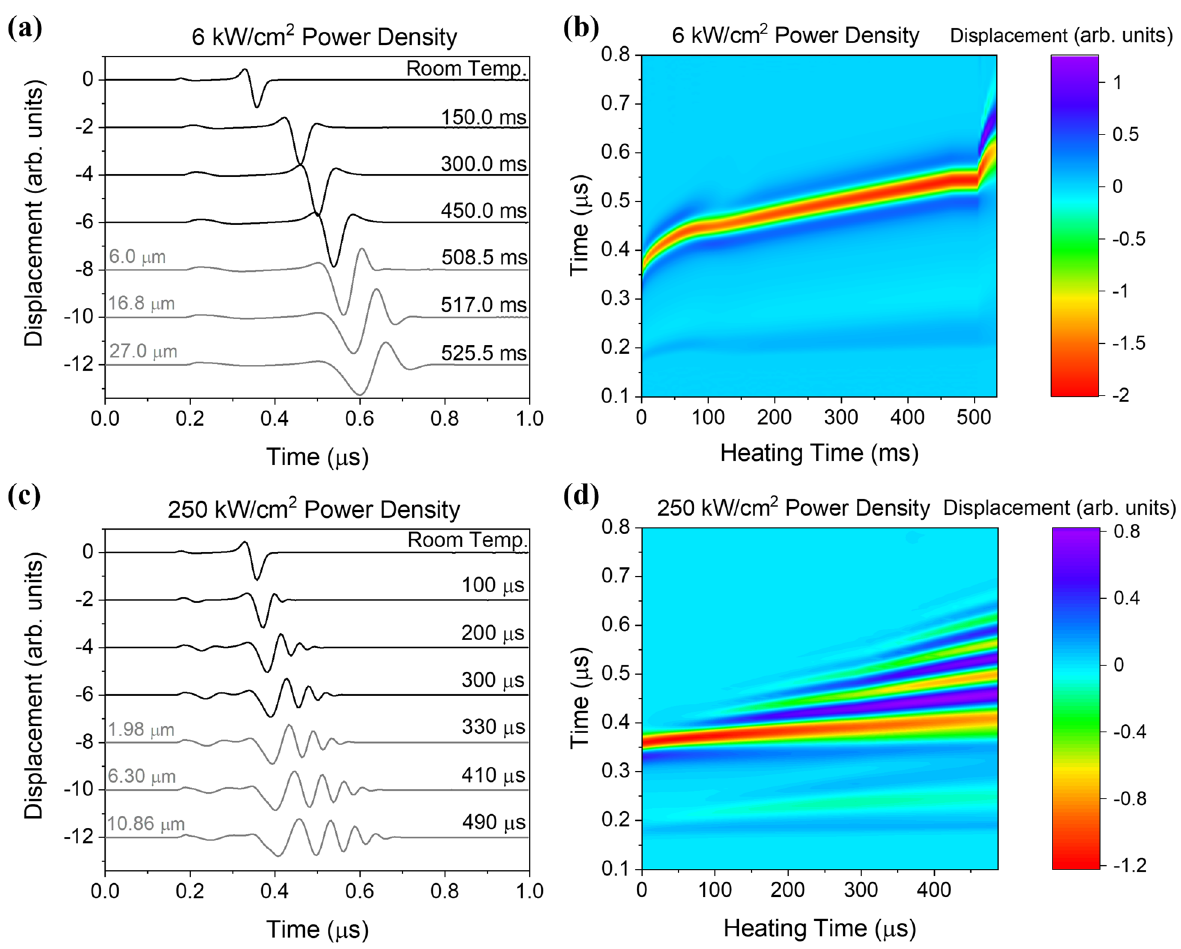
Figure 3. ( a ) Calculated laser ultrasonic signals with a source to detector distance of 1.0 mm at room temperature and heating times of 150.0, 300.0, 450.0, 508.5, 517.0, and 525.5 ms for a heating laser power density of 6 kW/cm 2 . ( b ) Temporal evolution of the displacement field for the 6 kW/cm 2 power density. ( c ) Calculated laser ultrasonic signals from the 250 kW/cm 2 heating laser power density at room temperature and heating times of 100, 200, 300, 330, 410, and 490 μs. ( d ) Temporal evolution of the displacement field for the 250 kW/cm 2 power the near surface region within the 500 μs time window as shown in Fig. 2d. These thermal gradients can cause dispersion of surface waves since the higher frequency waves, with a shorter wavelength, will be more influenced by the near surface region while lower frequency waves will penetrate further into the cooler substrate. This one-dimensional thermal model allows for the calculation of temperature as a function of depth and melt front position at any time after the heating laser is turned on. Next, the pulsed laser excitation and interferometric detection of the CW laser-heated surface at a given time is modeled. The material near the surface is discretized into 400 layers, with a layer thickness of 0.6 µm. The elastic properties of each layer are calculated from the mean temperature of the layer, and the elastic wave propagation problem is then reduced to an analogous problem of wave propagation in a homogeneous, isotropic layered media 41 . When surface melting occurs, the thickness of the surface layer is set as the thickness of the melt pool and the density 38 (3920 kg/m 3 ) and longitudinal wave velocity 39 (4407 m/s) of liquid Ti-6Al-4V are used. Laser generation of ultrasound in plates 42–44 and in multi- layer plates on a semi-infinite substrate 45 have been previously addressed by others. The approach presented by Cheng et al. is followed in which the excitation laser source is represented as an equivalent elastic boundary source (Gaussian in space with a 10 ns pulse width), and the transfer matrix technique is used to enforce the continuity of stress and displacement across all homogeneous and isotropic layer boundaries 41 . The problem is solved in cylindrical coordinates using the integral transform technique where a Hankel transform of the elastic wave equation is taken with respect to the radial coordinate ( r ) and a Laplace transform is taken with respect to time. The normal surface displacement as a function of time at a given r is found through numerical inversion of the Hankel-Laplace transforms.